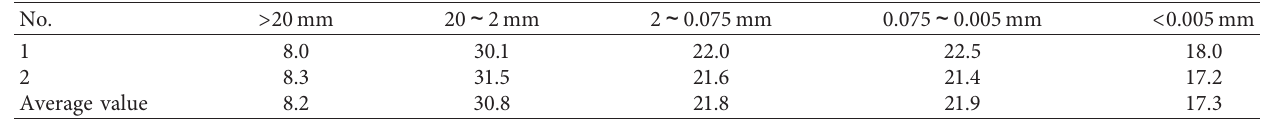
Table 2: Results of the particle size analysis test of the sliding zone soil.